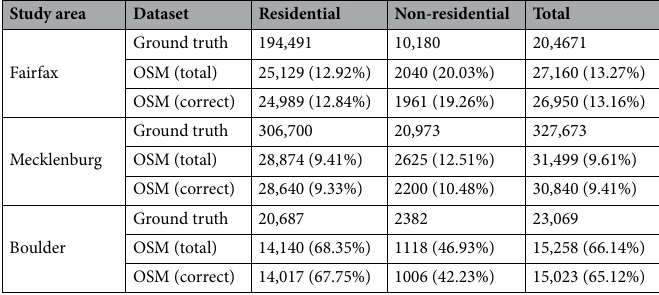
Table 1. Ground truth comparison with OSM data.